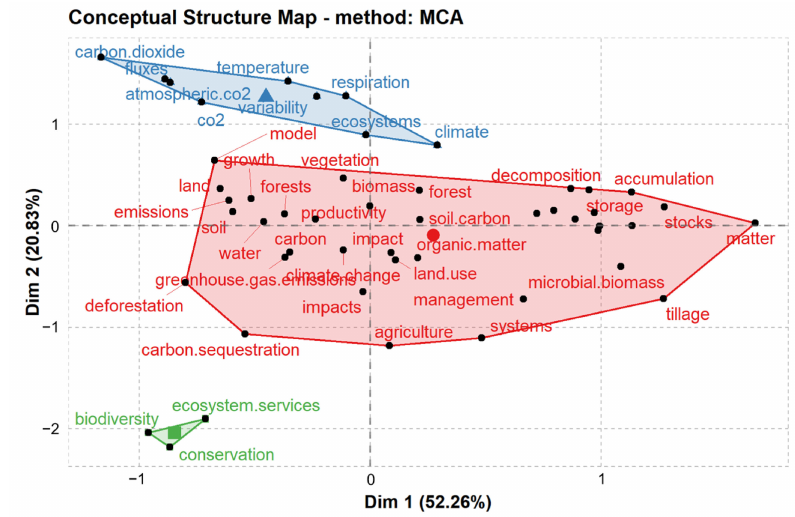
Figure 7. Cluster Analysis of Keywords in the Influence of Land Use Change on Soil Carbon Sequestration from 1985 to 2021.